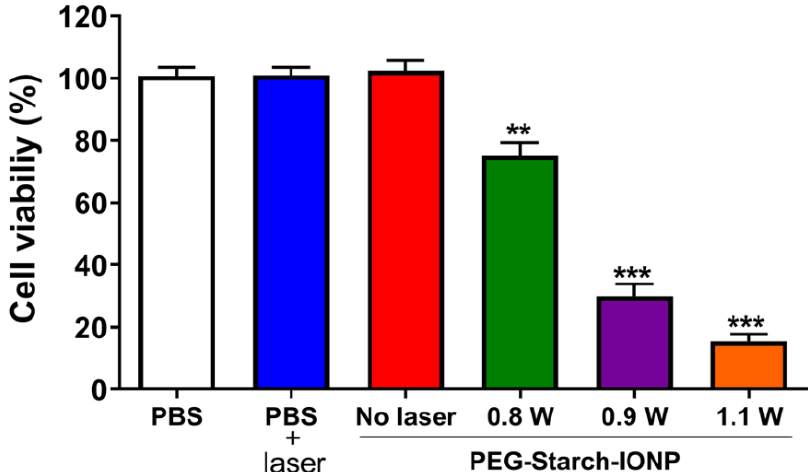
Figure 7. Cytotoxic effects of PEG–starch–IONPs-based photothermal treatment on U87 MG cells. The U87 MG cells were treated with either PBS or PEG–starch–IONPs (at 100 µ g Fe/mL), and then a laser was irradiated to the cells for 10 min at different laser powers (0.8, 0.9, or 1.1 W). The relative cell viability was determined by WST-1 assay. The statistically significant differences in the cytotoxicity levels were compared by one-way ANOVA (Tukey’s multiple comparison test as the post hoc test). ** p < 0.01, *** p <